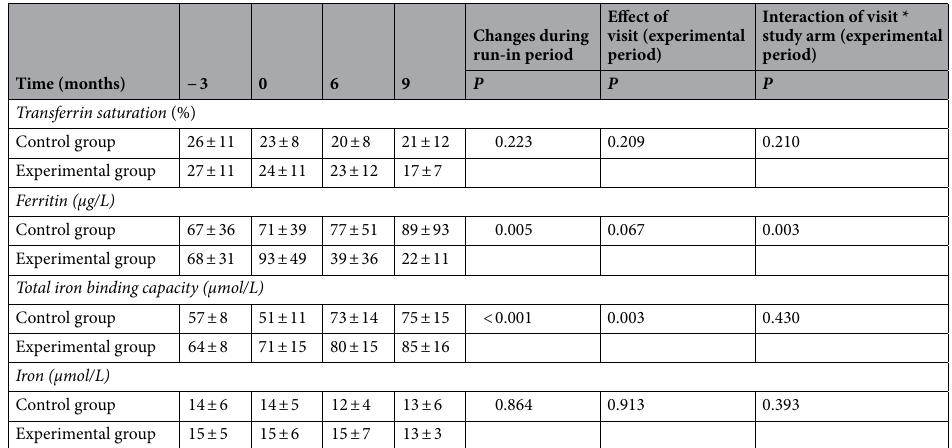
Table 4. Change in ferrokinetic parameters in each arm of the trial throughout the study. Continuous and discrete variables are mean ± SD. Changes during the run-in period were analyzed by paired t tests considering all women as a whole. The effect of visit and the interaction between the visit and study arm of the study throughout the experimental phase of the trial were analyzed by repeated-measures general linear